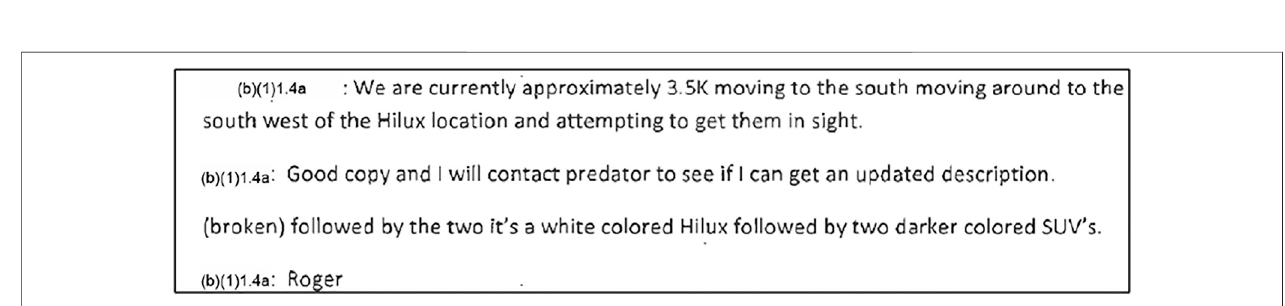
FIGURE 1 | Excerpt from the Predator transcript.